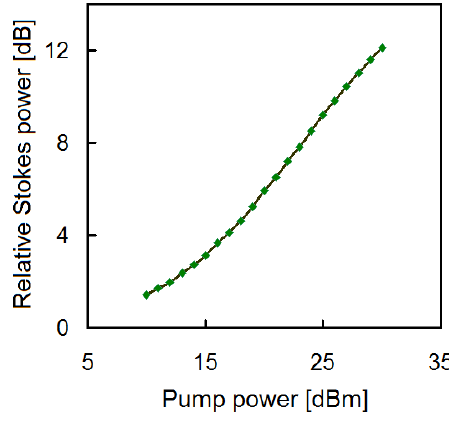
Figure 3. Relative power of the Stokes light backscattered from 100 m PFGI-POF vs. pump